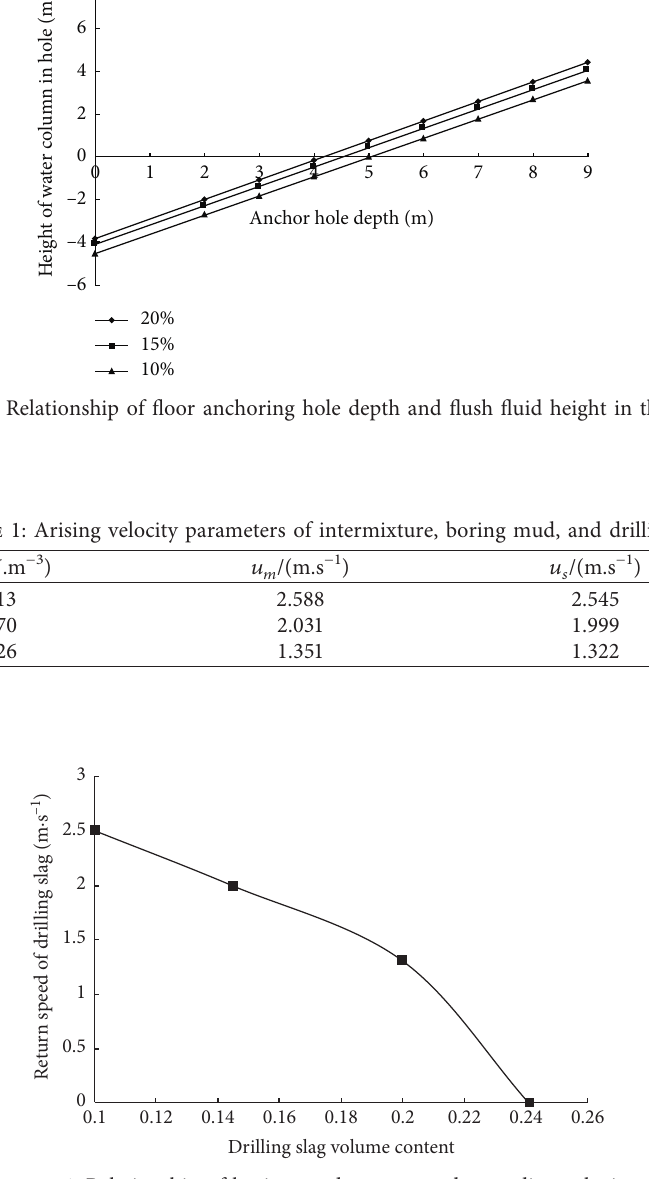
Figure 4: Relationship of boring mud content and ascending